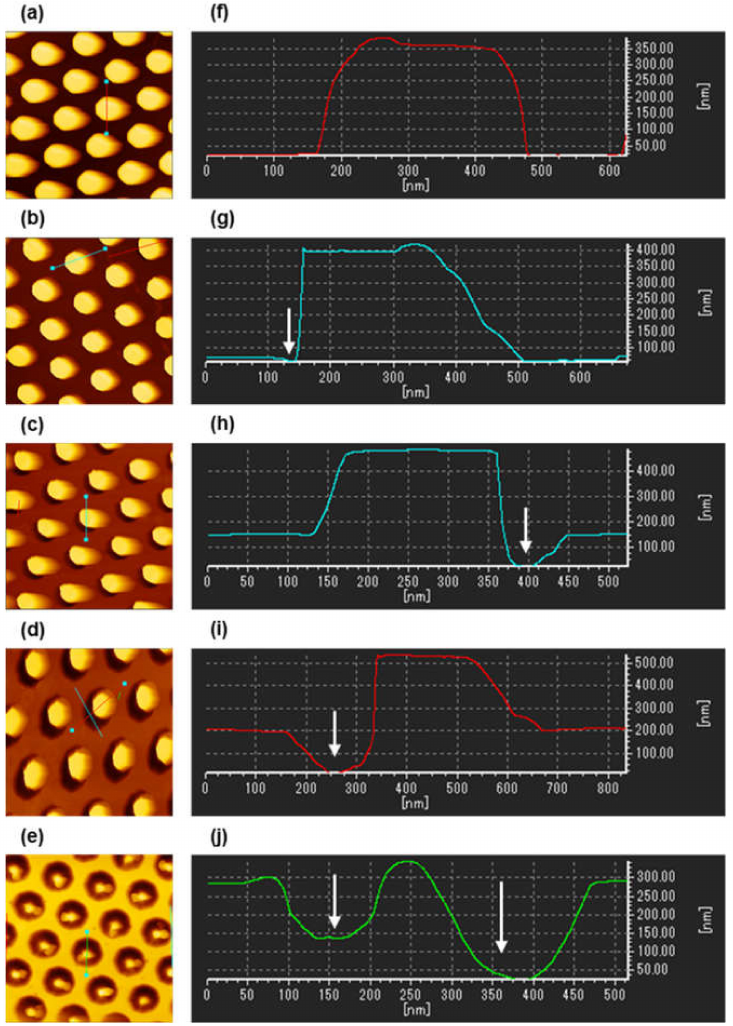
Figure 3. ( a – e ): AFM images (2 µ m × 2 µ m) of re-shaped COP molds processed over different etching times: ( a ) 0 min, ( b ) 5 min, ( c ) 10 min, ( d ) 15 min, and ( e ) 20 min. The line between the two light blue squares indicates the profile line required to obtain a cross-sectional profile. ( f – g ): Cross-sectional profile of re-shaped COP molds processed over different etching times: ( f ) 0 min, ( g ) 5 min, ( h ) 10 min, ( i ) 15 min, and ( j ) 20 min. The white arrows in the figures indicate the pits formed at the bottom of